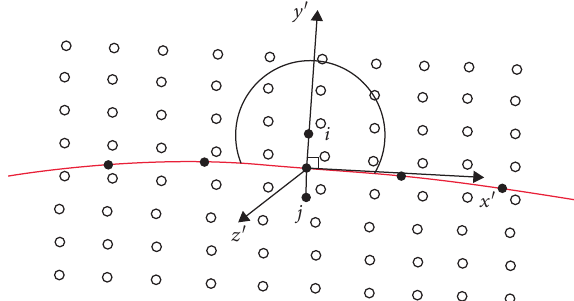
Figure 1: Schematic diagram of the local coordinate